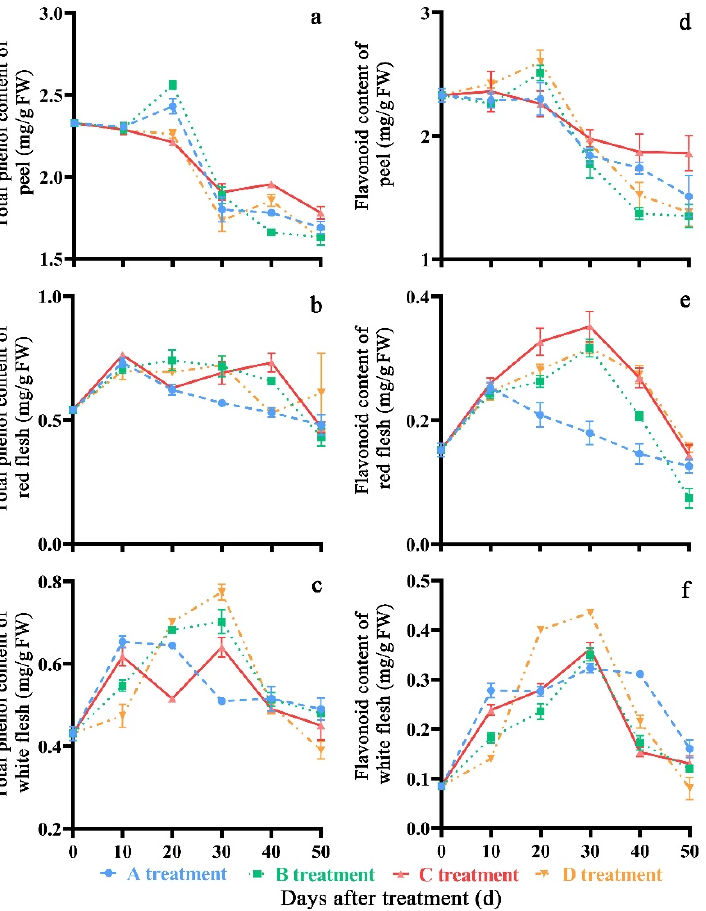
Figure 6. Changes in total phenol ( a – c ) and flavonoid ( d – f ) content of ‘Yonglian No.1’ peach fruits during storage in four treatments. Vertical bars represent the standard errors. The different lower case letters at each time point indicate significant difference at p < 0.05 using Duncan’s multiple range tests.